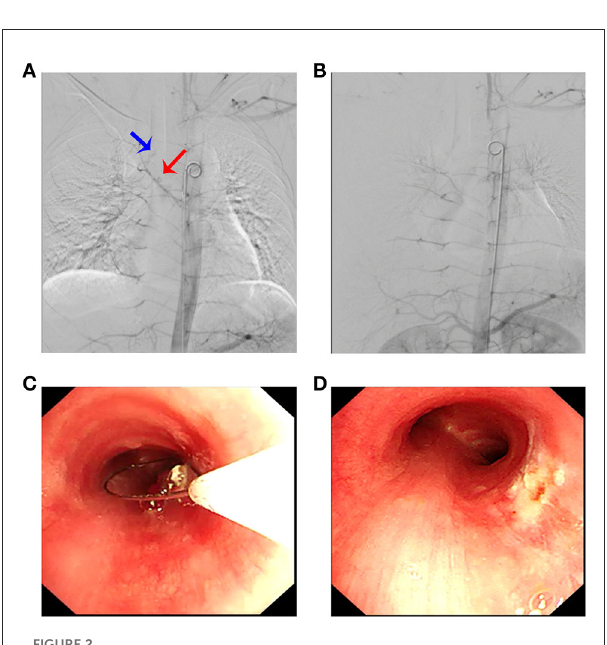
FIGURE2 Arteriography revealed a pathological artery originating from the bronchial artery (A) (blue arrow: tumor; red arrow: bronchial artery branch) that was selectively embolized (B) . (C) Electrocautery loop snaring via flexible bronchoscopy; (D) posttreatment view of the same